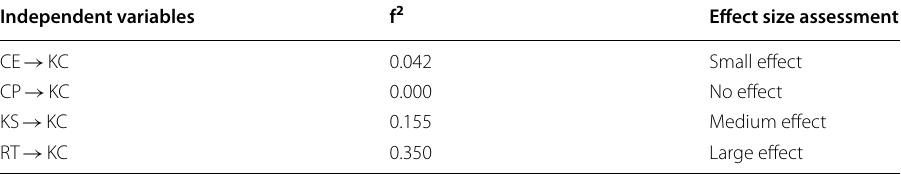
Table 6 Effect sizes for path coefficients